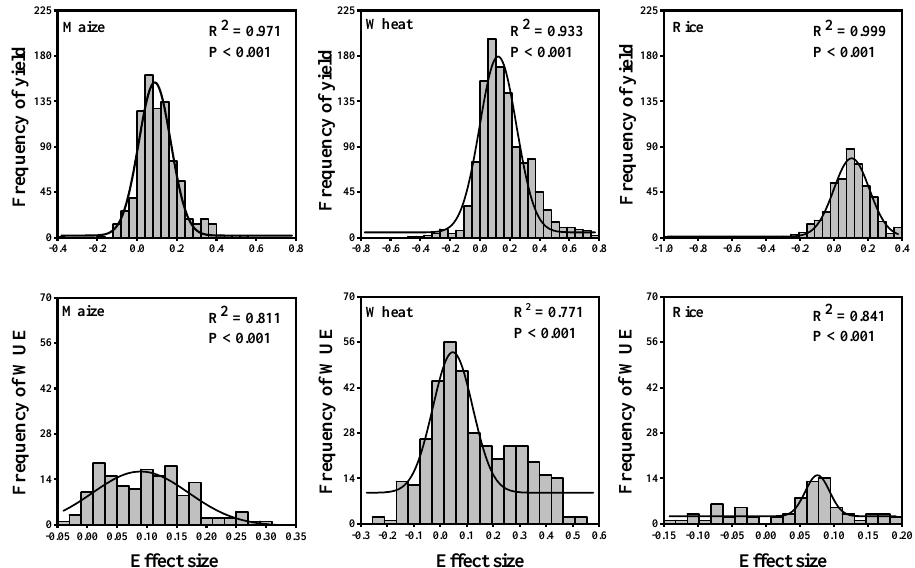
Figure 2. Frequency distribution of effect sizes for crop yield and WUE of maize, wheat, and rice. The solid lines are normal (Gaussian) distributions fitted to frequency datasets.